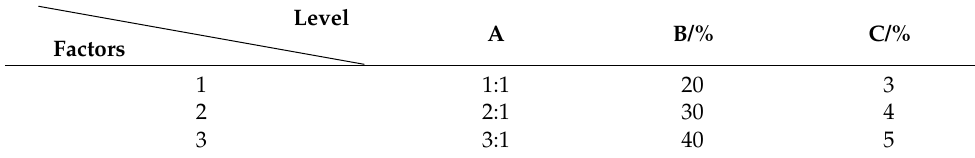
Table 1. The orthogonal experimental factors and levels.